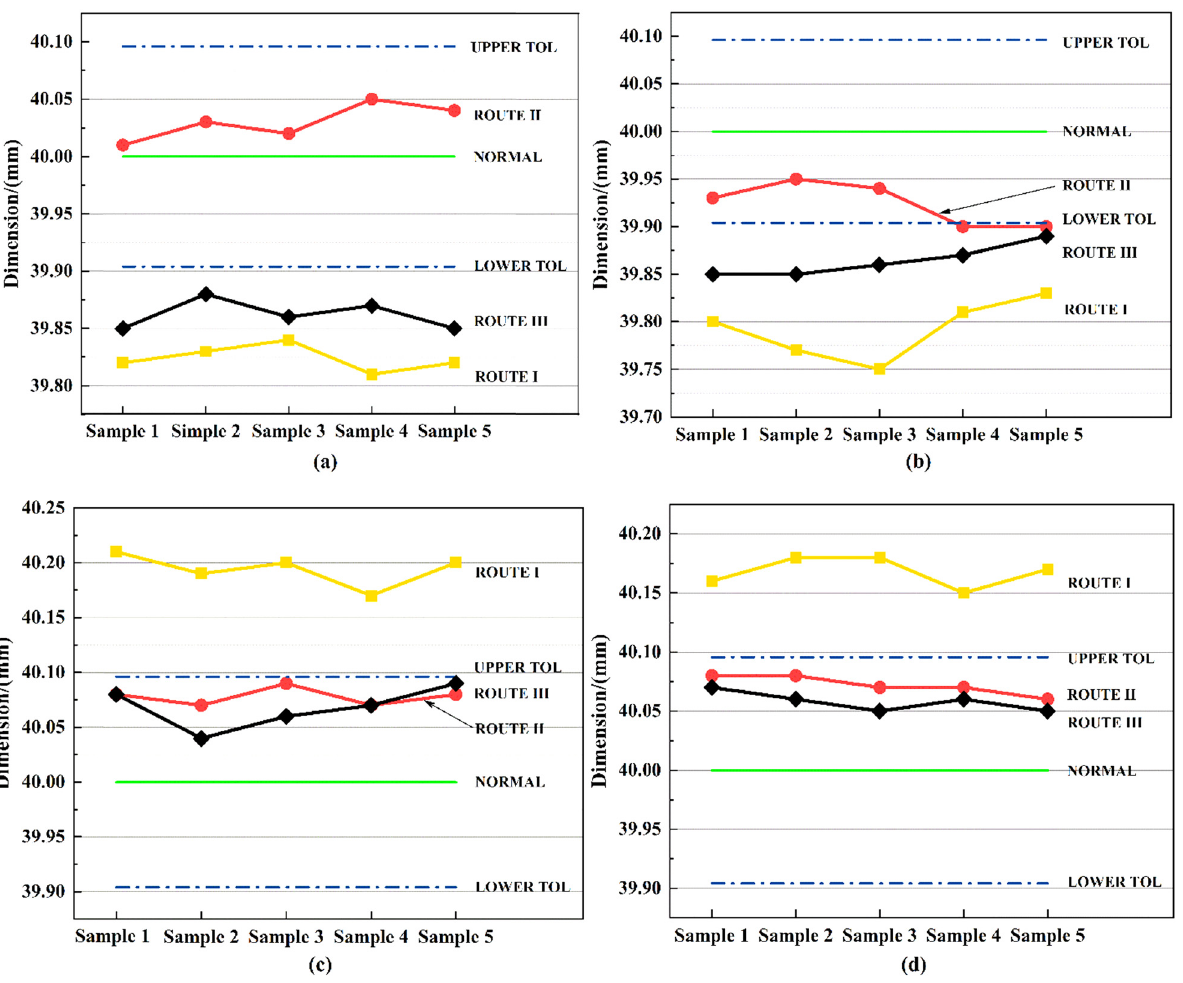
Figure 6: The central hole diameter of the plate by the three routes: ( a ) DDT, undried parts, ( b ) DDT, dried parts, ( c ) DDL, undried parts, and ( d ) DDL, dried